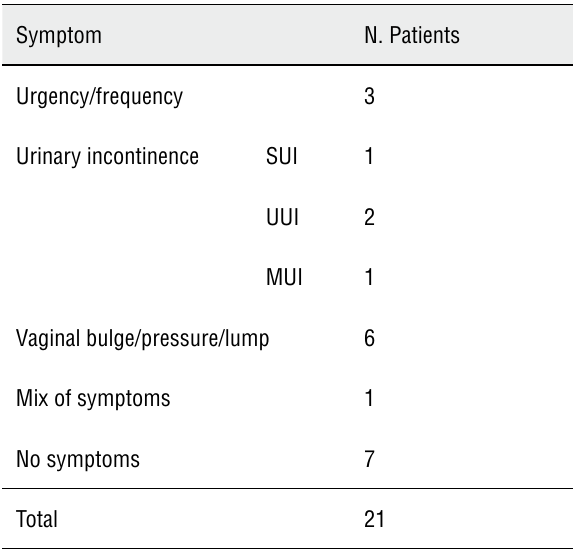
Table 3 - Symptoms in patients with recurrent